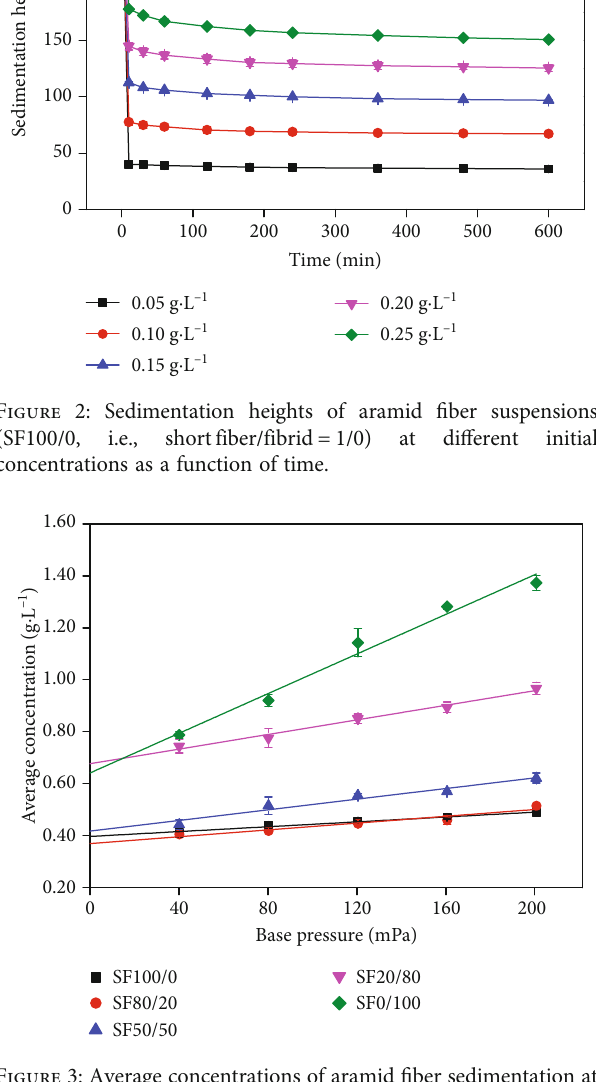
Figure 3: Average concentrations of aramid fi ber sedimentation at di ff erent fi ber/ fi brid ratios as a function of base